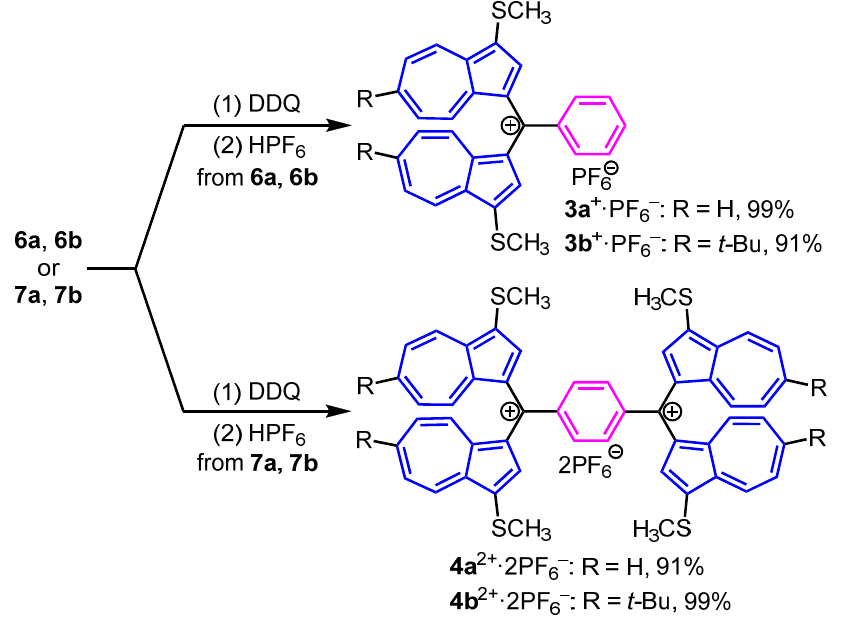
Figure 3. Synthesis of cation 3a , b + ·PF 6 − and dications 4a , b 2+ ·2PF 6 − . Spectroscopic properties : Cations 3a , b + ·PF 6 − and 4a , b 2+ ·2PF 6 − were fully characterized by spectroscopic data, as appears in the “Materials and Methods” section. High-resolution mass spectra (HRMS) revealed the correct molecular ion peaks. The chemical shifts in 1 H NMR spectra of the azulene moiety for 3a , b + ·PF 6 − and 4a , b 2+ ·2PF 6 − revealed low-field shifts compared with those of 6a , b and 7a , b, attributing to the electron-withdrawing property of the methylium ion attached.